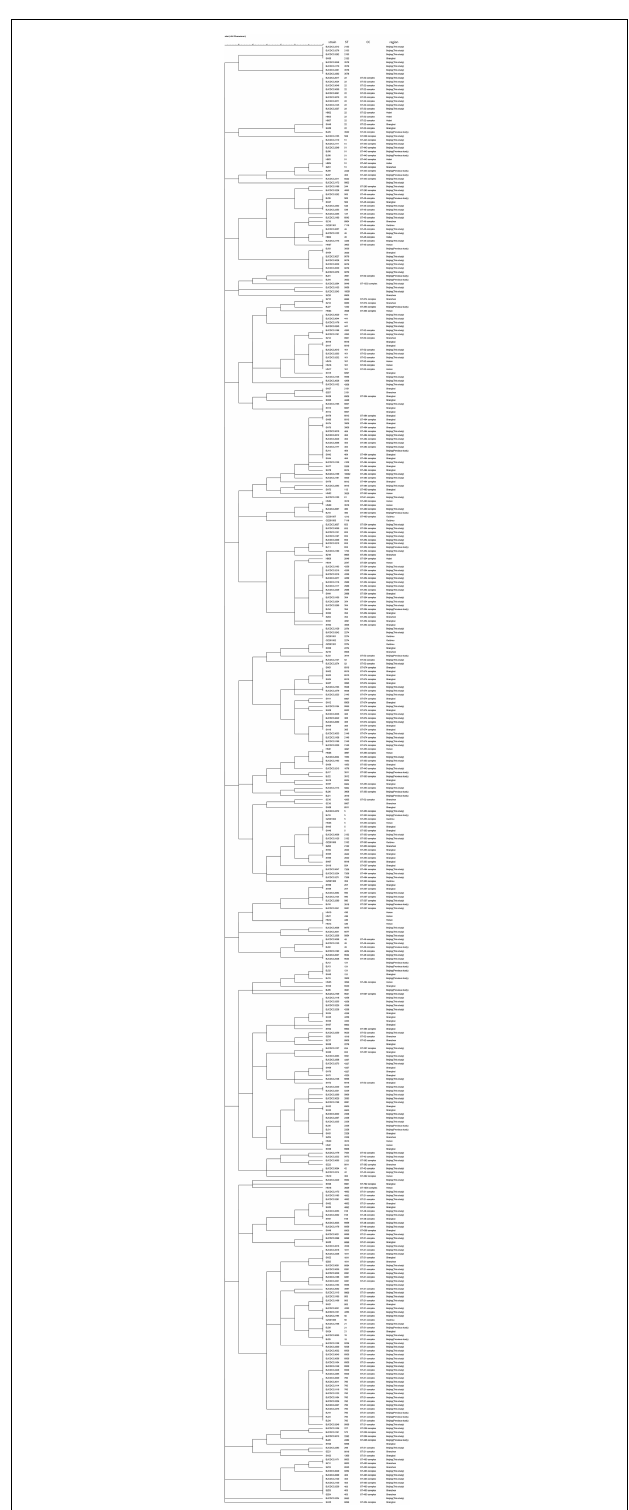
FIGURE 3 | Dendrogram of MLST data of C. jejuni human isolates collected from this study and other district of China, Showed the number of differences in MLST alleles. The similarity coefficient were calculated using the categorical (difference) and complete linkage for the cluster analysis.